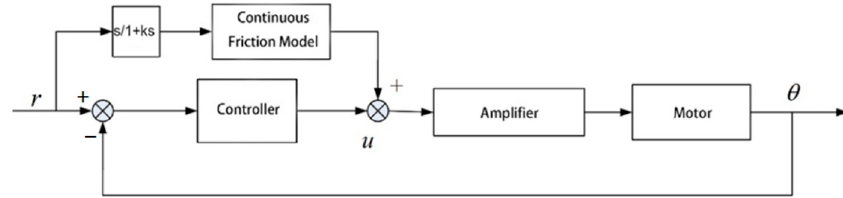
Figure 5. Frictional feedforward compensation diagram.